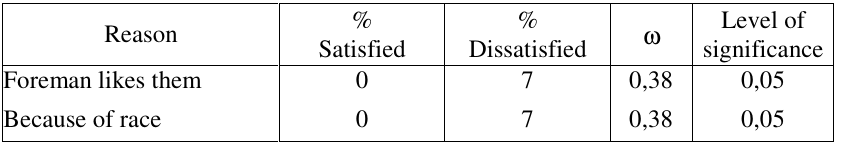
PERCENTAGE RESPONSES OF SATISFIED AND DISSATISFIED WORKERS REGARDING WHY CO-WORKERS EARNED MORE